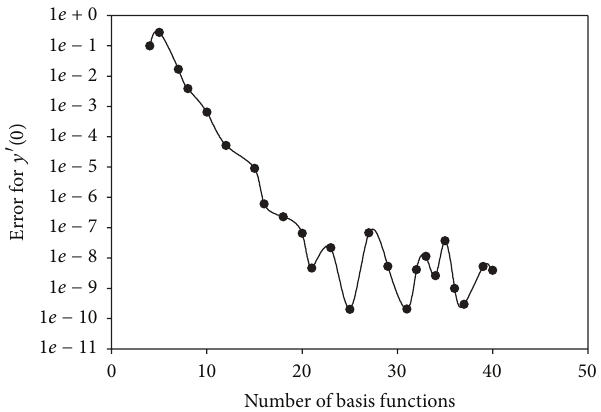
Figure 3: Detailed presentation of the convergence rate of the initial slope 𝑦 󸀠 (0) for an exponential basis set defined with the following parameters: 𝑠 = 5 , 𝑑 𝑠 = −4 ,and 𝑑 𝑙 = 2 .